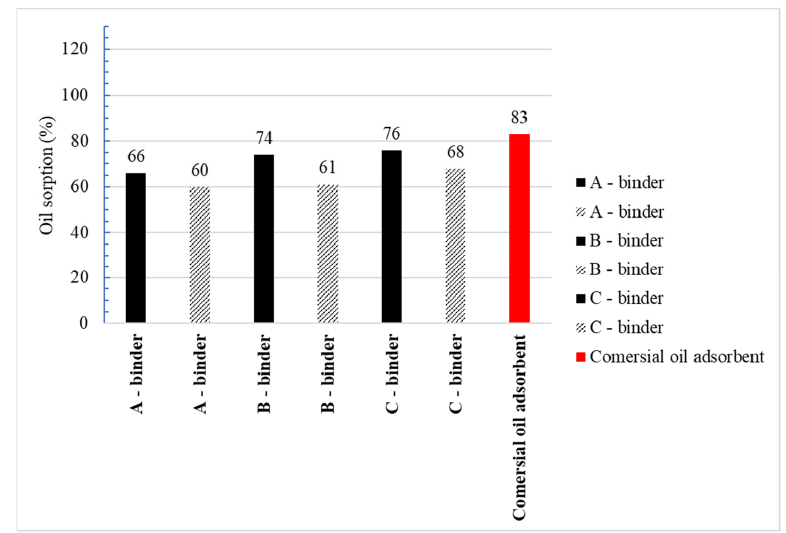
Figure 19. Oil sorption agglomerates and commercial adsorbent.